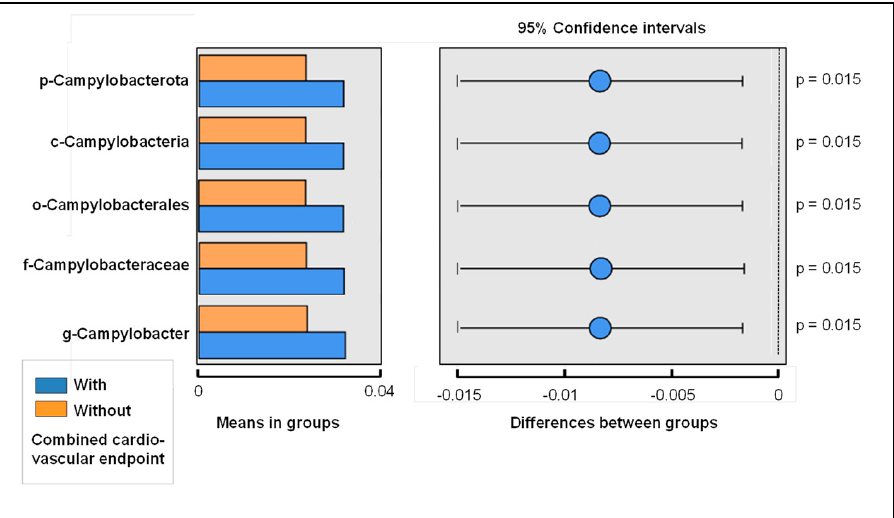
Figure 4. Differences in means comparing patients with and without a combined cardiovascular endpoint according to the MACCE criteria in the 3 ‐ year follow ‐ up ( t ‐ test, including a Benjamin– Hochberg false discovery rate of 5%).